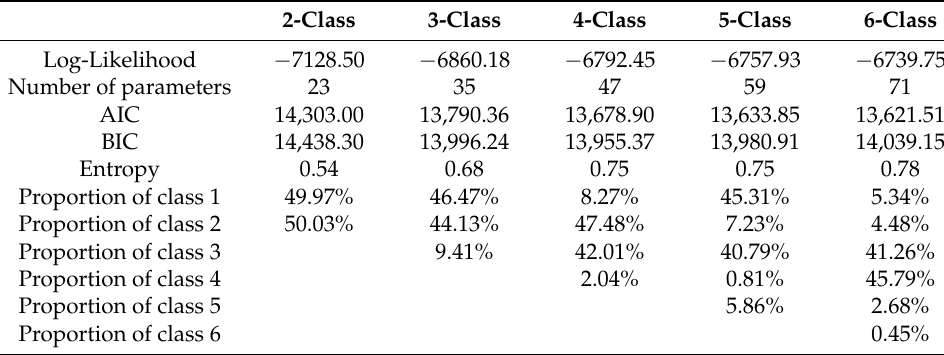
Table 3. Fit indices for unconditional latent class models.